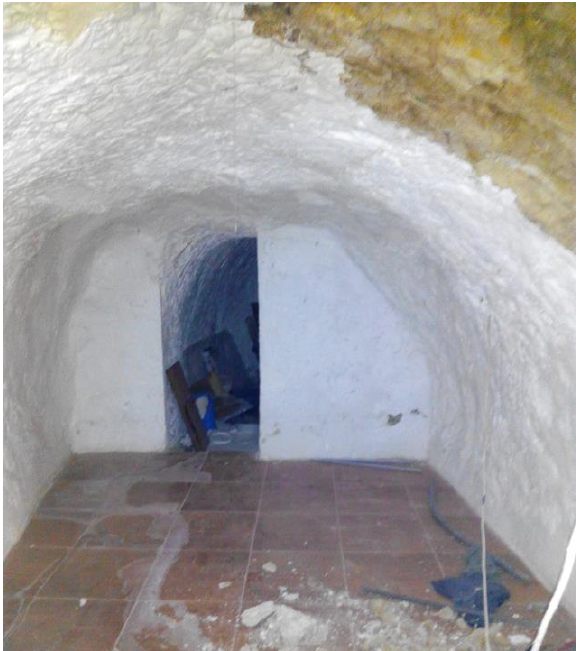
Figures 12. Detail of the interior of the casón on calle Mizas